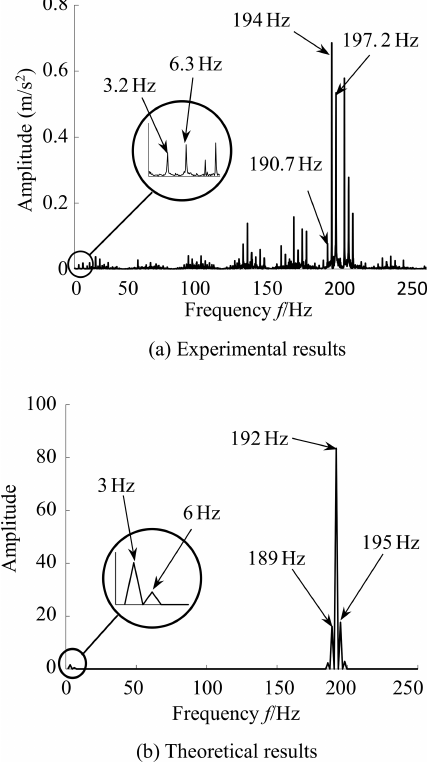
Figure 17. Frequency–amplitude